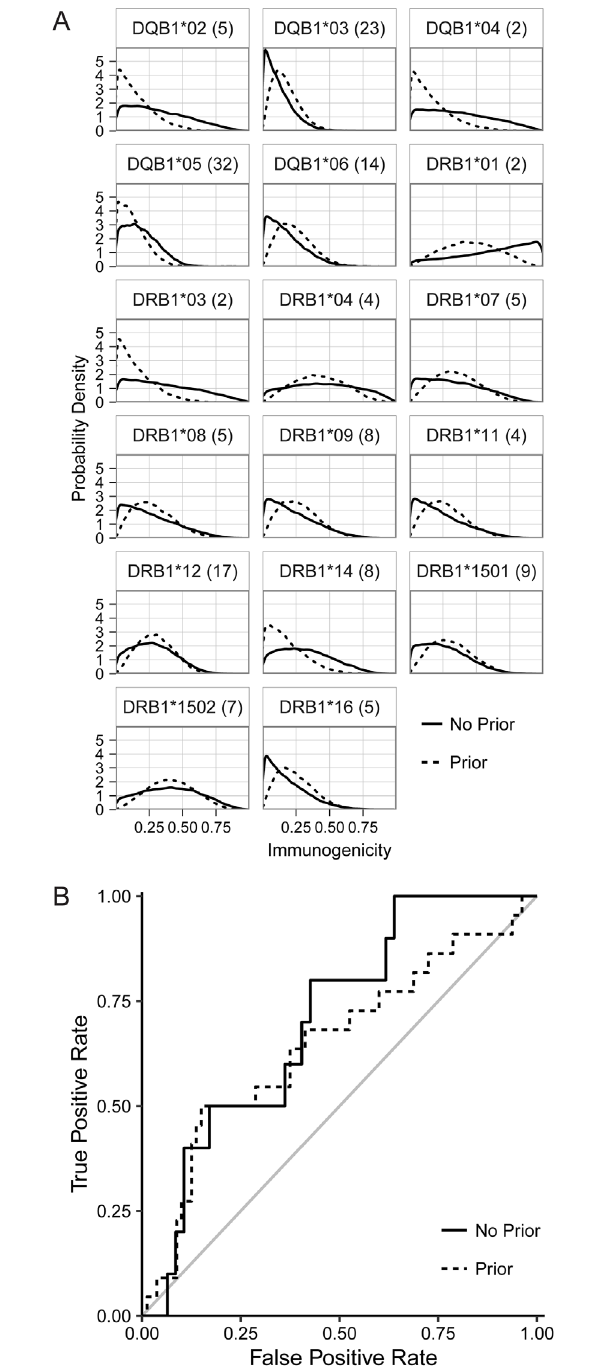
Fig 2. Application of the algorithm to the Burkholderia data set, with (dashed lines) and without (solid lines) inclusion of prior information. (A) Marginal posteriors of the peptide:HLA immunogenicities for BPSL2096 1 – 20 (Allele count in the cohort in brackets). (B) ROC curves were generated by comparing the mode of the posterior distributions against the transgenic mouse data set. For these curves, we have removed all posterior distributions whose Kullback-Leibler divergence with respect to the uniform distribution on the unit interval was smaller than that of the Beta(1,2) distribution.